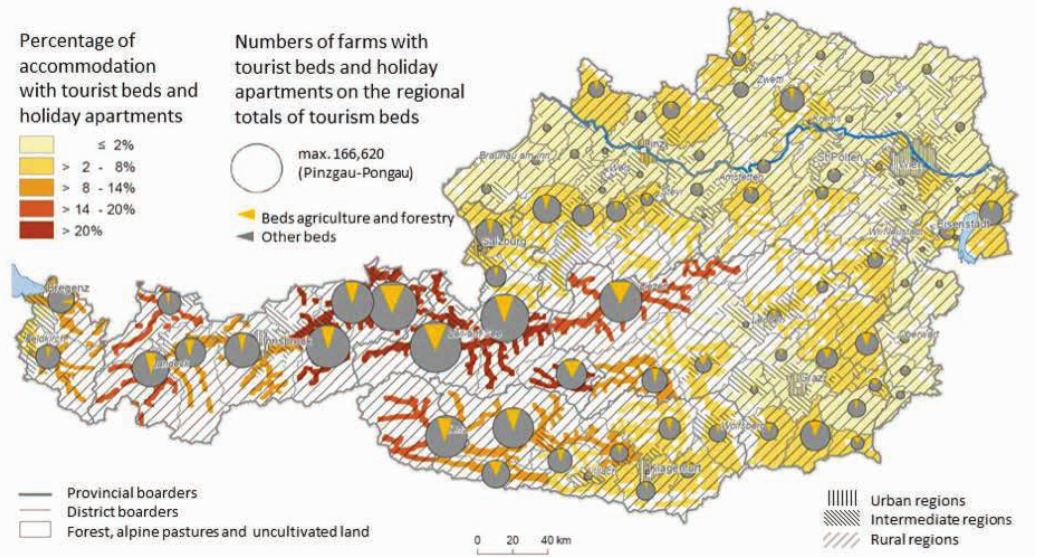
Figure 3: Regional statistics of tourism 2010 – number of tourist beds (totals and farms) by districts and NUTS3 regions (Statistics Austria